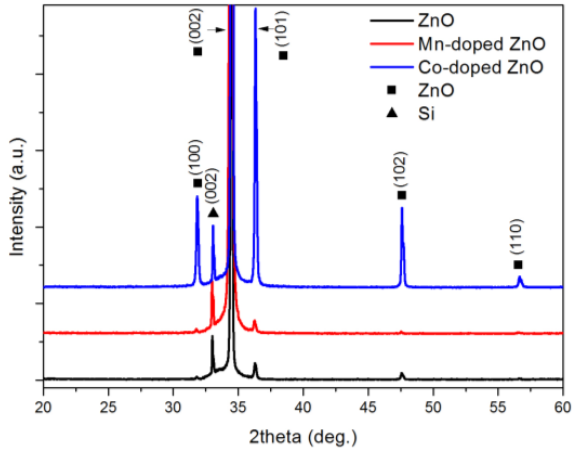
Figure 1. X-ray diffraction (XRD) pattern of ZnO, Mn-doped ZnO and Co-doped ZnO.